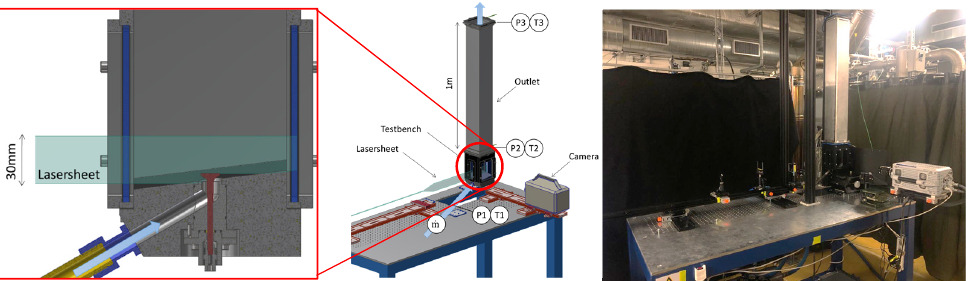
Figure 2. Cross-section through the optical chamber of OTB1 ( left ), the experimental setup ( middle ), and a photo of the experimental setup ( right ).